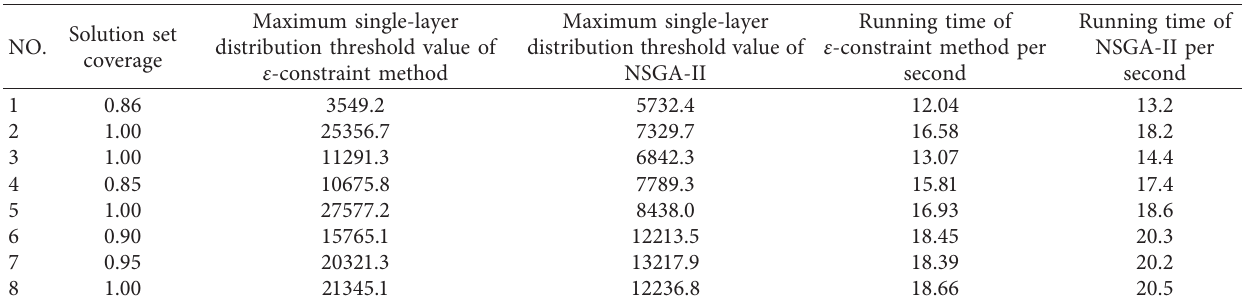
Table 9: Results of the comparison between the ε -constraint method and NSGA-II